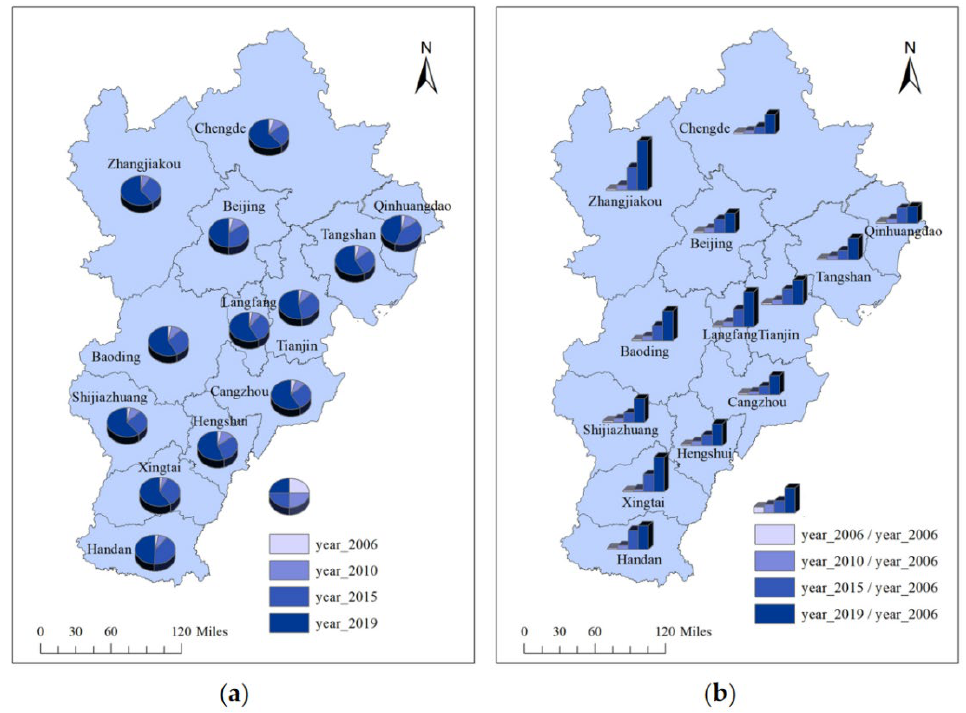
Figure 5. Spatial distribution of patent grants and growth rates in BTH. ( a ) Spatial distribution of patent grants in BTH; ( b ) spatial distribution of growth rates in BTH. Figure source: authors’ own creation. Data from the China City Statistical Yearbook .